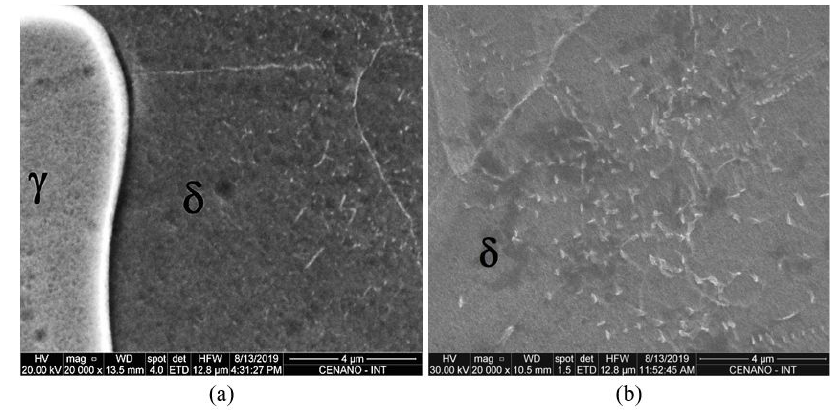
solution (1.1 V,60 s): (a) ST-1050; (b) ST-1150. Figure 4. Specimens etched with 40% HNO 3 Table 2. Phase volume fractions of phases determined by quantitative metallography (ASTM E-562 13 ) and by simulation ( Thermo-Calc ® ). Specimen